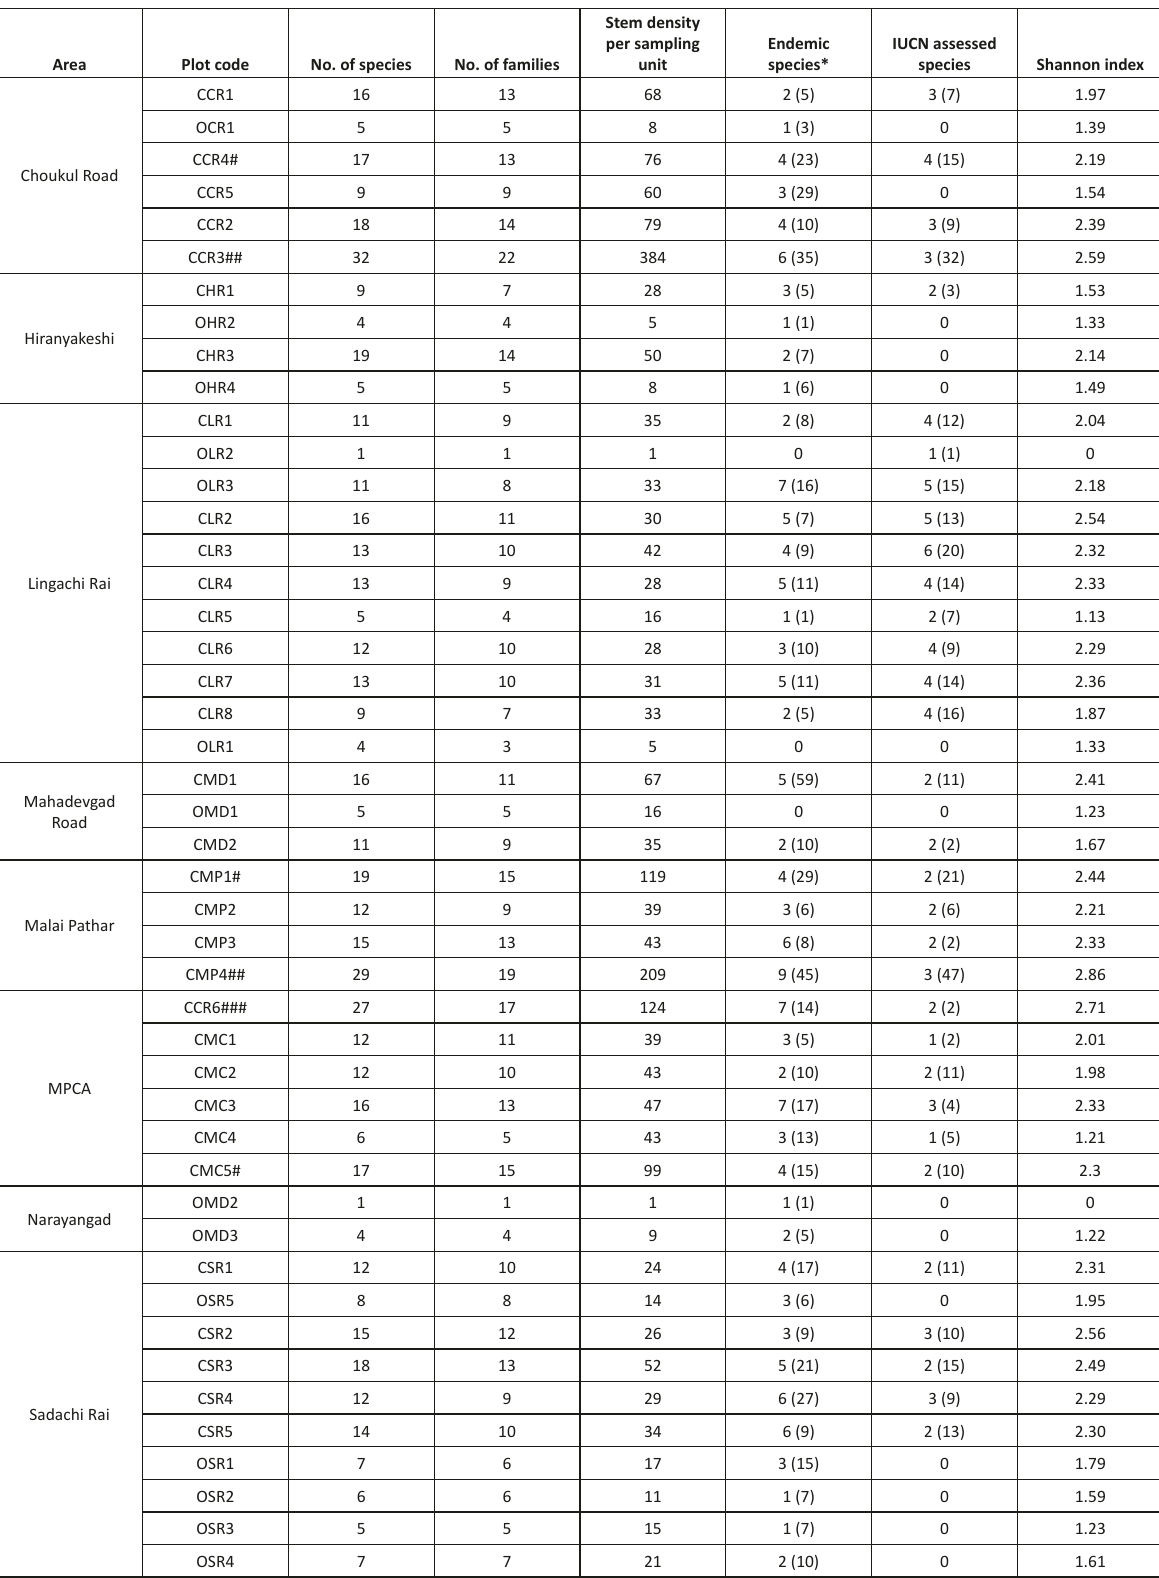
Table 1. Diversity parameters in the sampled plots. Area Plot code No. of species No. of families